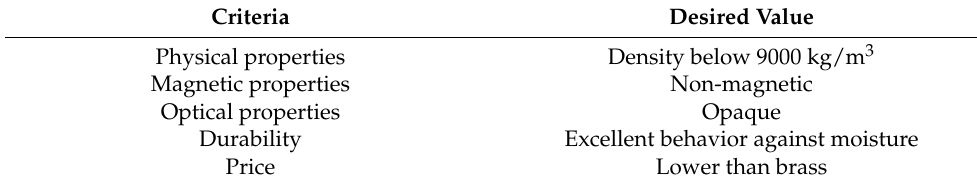
Table 1. Defined criteria for material